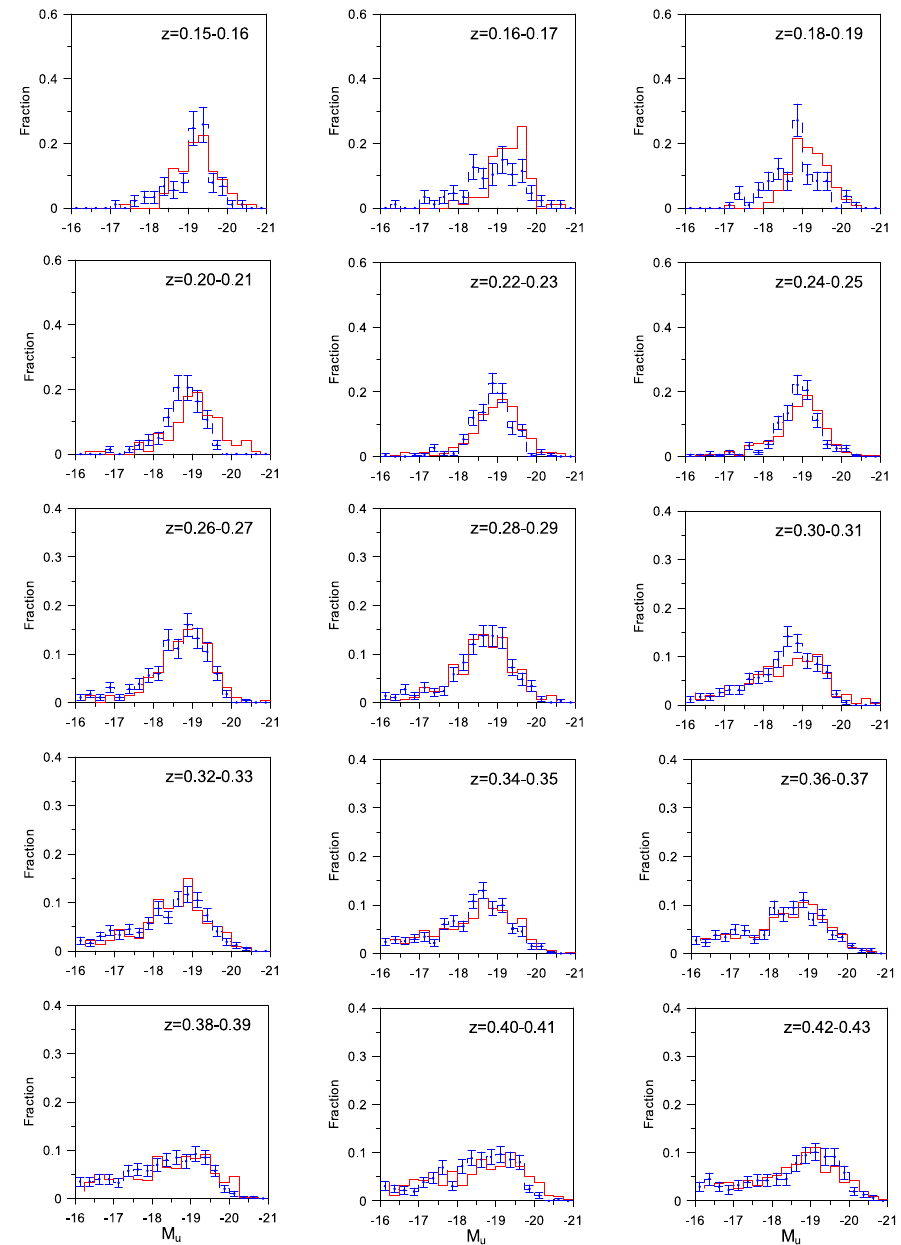
Fig. 1. u -band absolute magnitude distribution at both density extremes in dif- ferent redshift bins: red solid line represents the sample at high density, blue dashed line represents the sample at low density. The error bars of the blue lines are 1 (cid:27) Poissonian errors. The error-bars of the red lines are omitted for